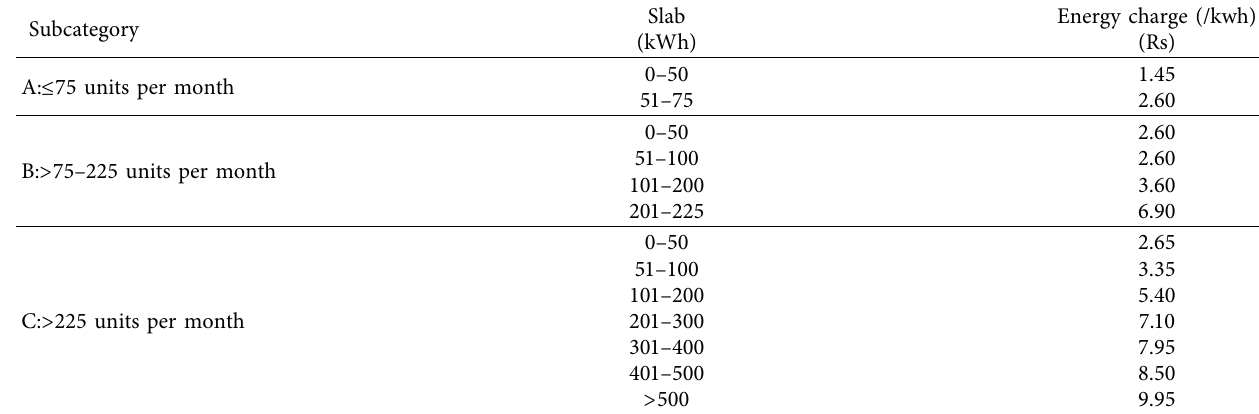
Table 2: APERC telescopic tariff for domestic